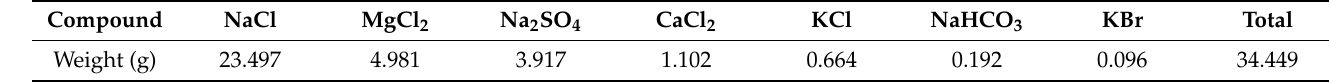
Table 2. The weight of compounds in each 1000 g of simulated